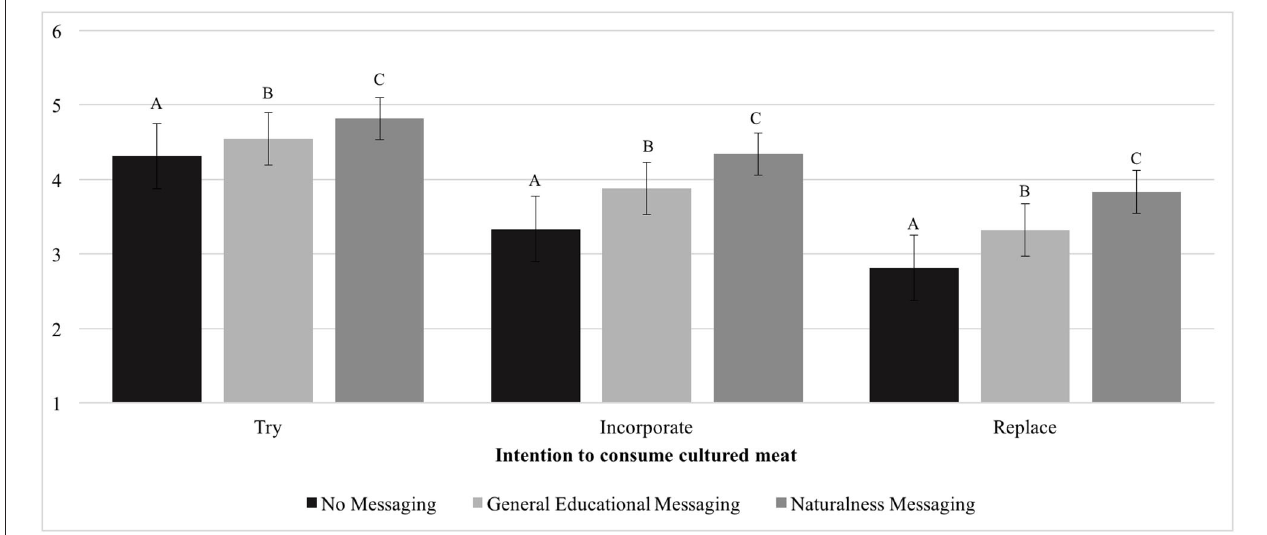
FIGURE 3 | Intention to try cultured meat, incorporate cultured meat into regular diet, and replace farmed meat/meat alternatives with cultured meat in regular diet across messaging treatments. Data shown are average responses from 7-point Likert scale (1 = “extremely unlikely” 7 = “extremely likely”) ± standard error. A, B, and C represent significant differences between the messaging treatments (Bonferroni 0.05